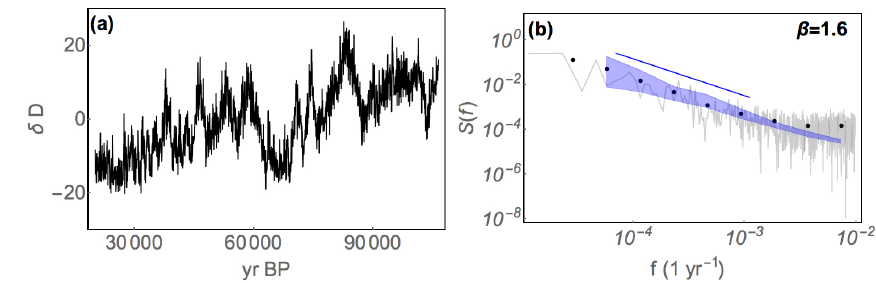
Figure 15. (a) δ D anomalies from the last glacial period part of the EDC ice core. (b) Periodogram for the time series in (a)